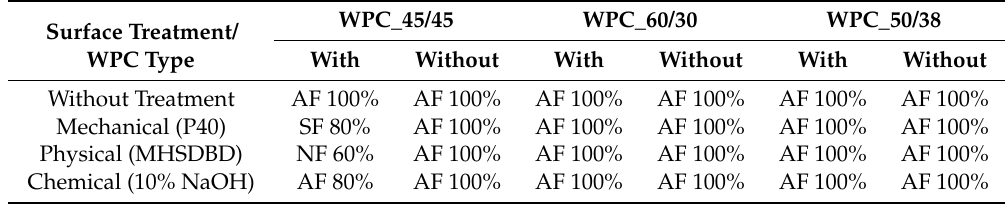
Table 2. Predominant failure mode of samples WITH and WITHOUT primer after tensile test 1 .